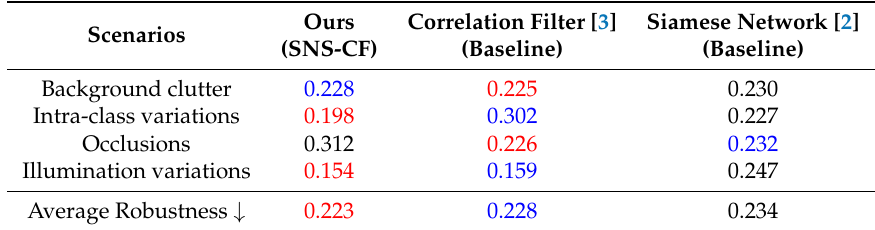
Table 4. Comparison of robustness on different SOT challenging problems with correlation filter, Siamese network, and the proposed SNS-FC algorithm. We present the results on VOT-2018 [9]. Red and blue numbers indicate the best and second best results, respectively.